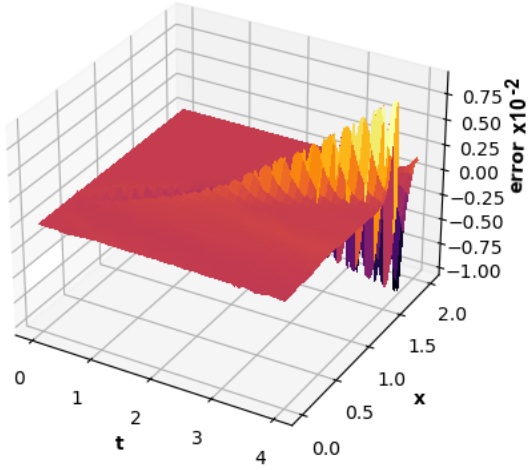
Figure 9. Error N = 100 for Example